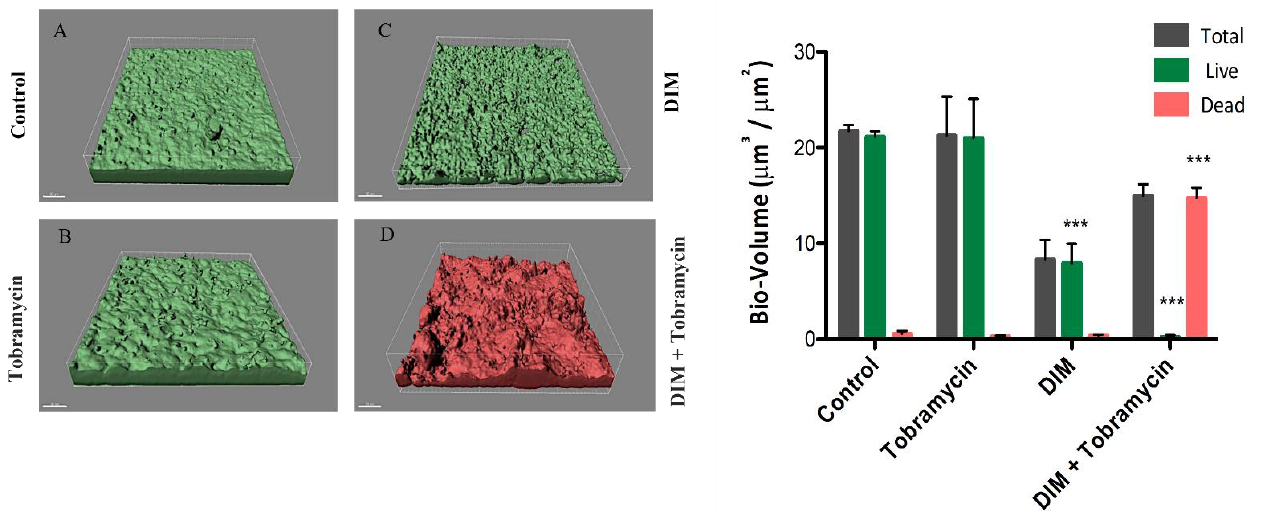
Figure 2. Destruction of mature, differentiated biofilm of P. aeruginosa PA01. CLSM images of biofilm formed in a flow system after 120 h ( A ) and continuous supplementation with ( B ) 20 µ g mL − 1 tobramycin, ( C ) 50 µ M DIM, and ( D ) a combined treatment of 50 µ M DIM with 20 µ g mL − 1 tobramycin, three independent repetitions. Biofilms were stained with the LIVE/DEAD bacterial viability